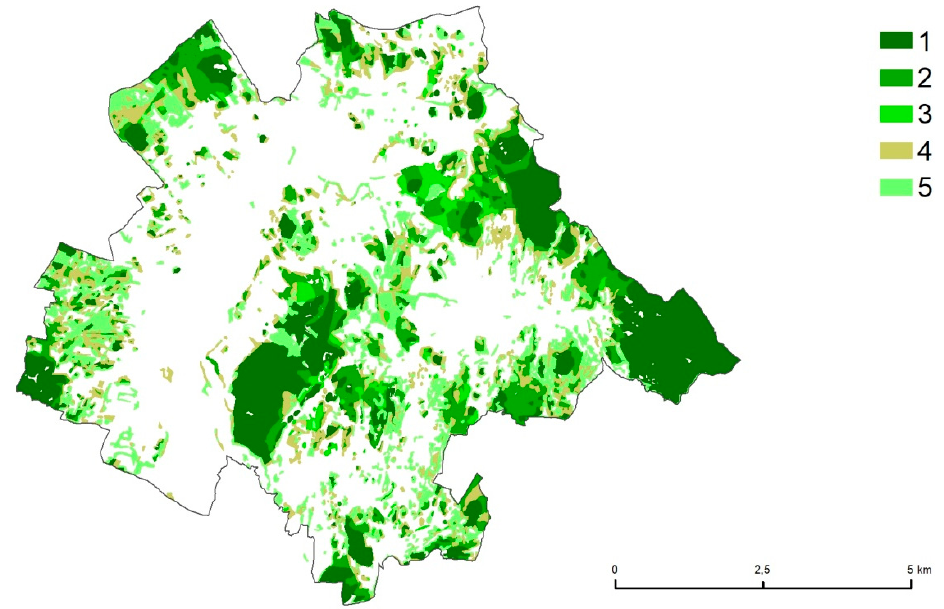
Figure 4. Time depth: ( 1 ) pre-1824, ( 2 ) 1824–1886, ( 3 ) 1886–1939, ( 4 ) 1939–1994, and ( 5 ) 1994–2016.